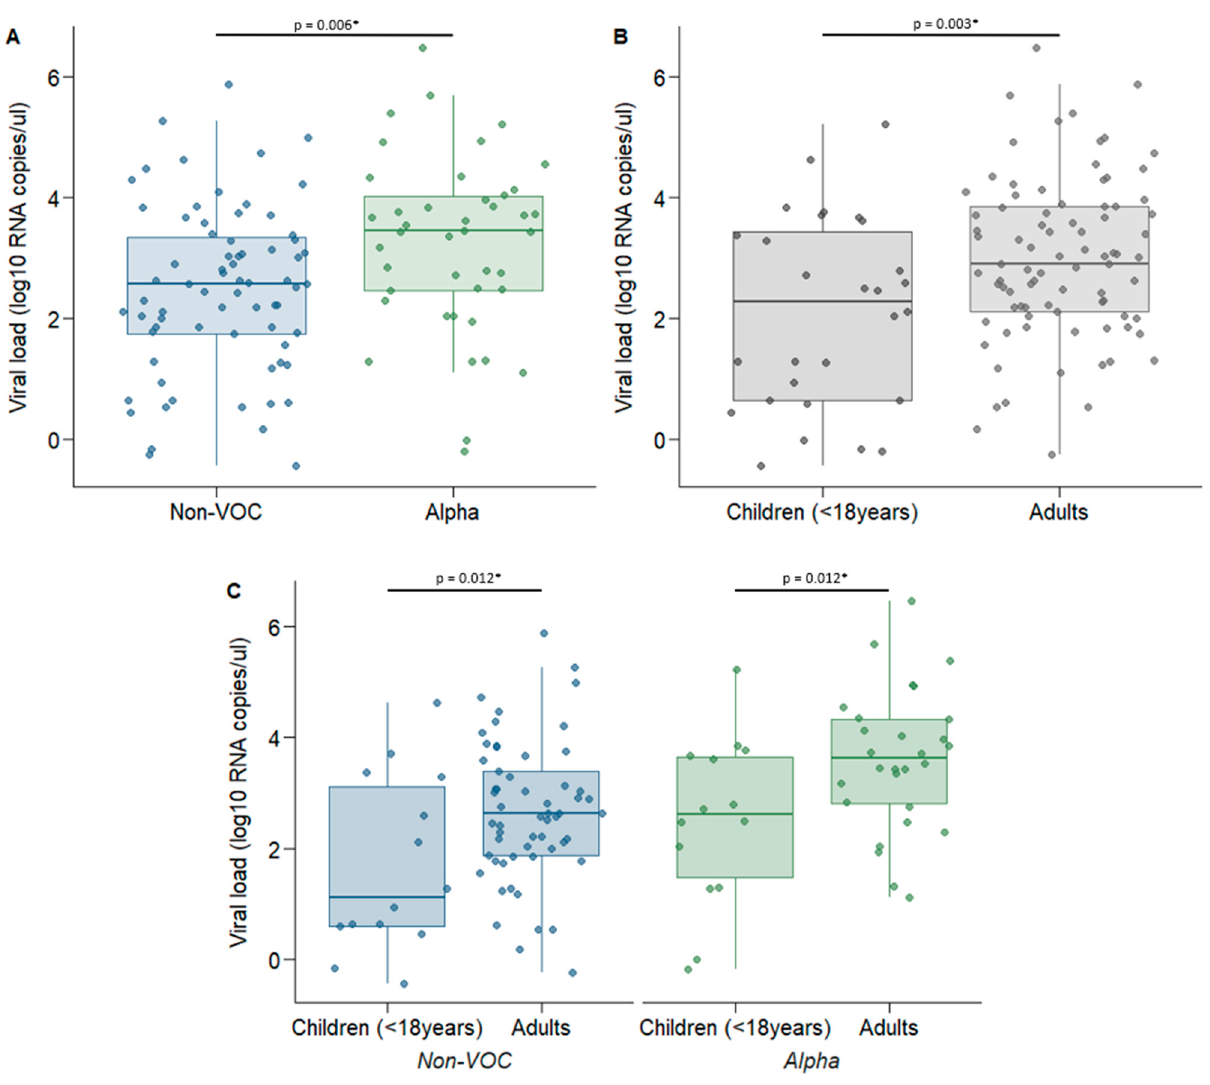
Figure 3. Comparison of viral load (log 10 RNA copies/µL eluate) measured by ddPCR for genetic variant and age groups The saliva sample with the lowest Ct value for each participant was selected for quantification of viral load using ddPCR. ( A ) Comparison of viral load between non-VOC ( n = 71) and Alpha viruses ( n = 42), ( B ) Comparison of viral load between children ( n = 28) and adults ( n = 85) for all genetic variants combined, ( C ) Comparison of viral load for genetic variants and age groups: non-VOC; children ( n = 14) versus adults ( n = 57), and Alpha variant; children ( n = 14) versus adults ( n = 28). * p < 0.05. p -Values were estimated using a mixed-effects linear regression.